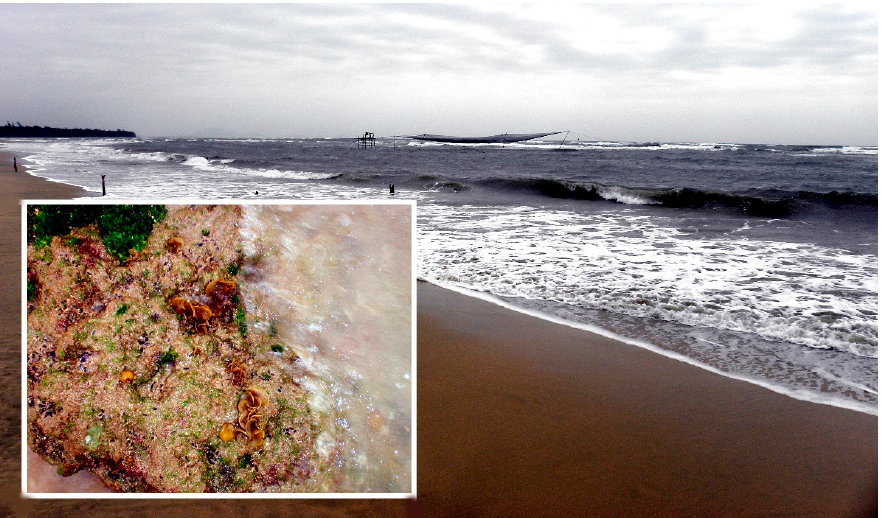
Figure 5. The vicinity of Wenchang City. Inset: Padina arborescens in association with turf algae in the middle intertidal zone, March 2012.